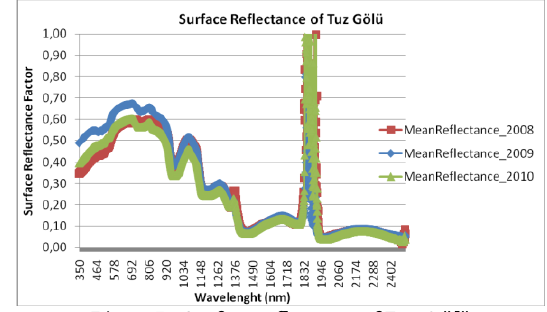
Figure 7. Surface reflectance of Tuz